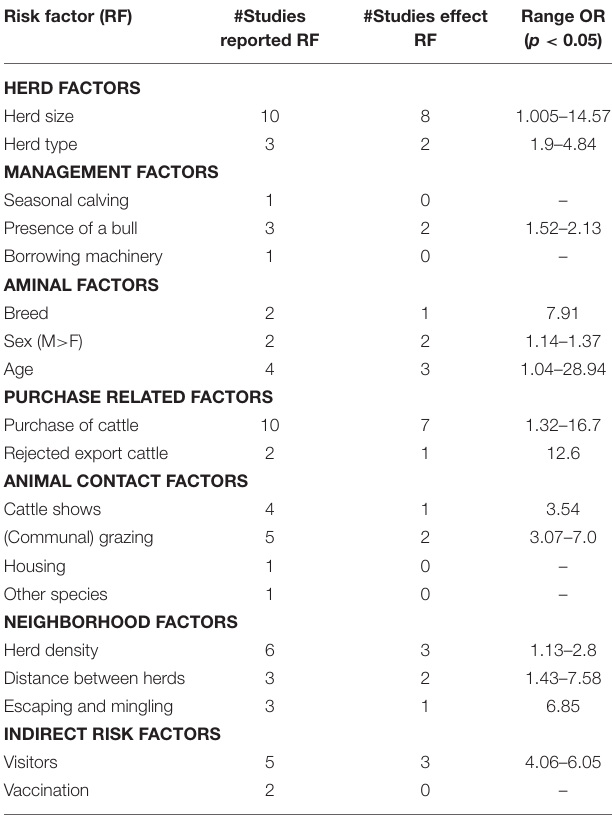
TABLE 2 | Summary of studied risk factors for introducing BoHV-1 into cattle